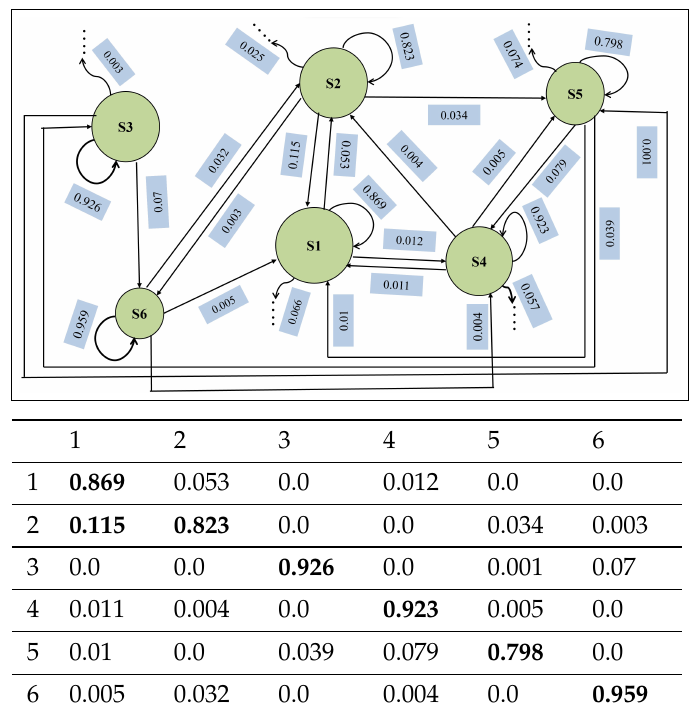
Figure 7. In each case, macro-states are drawn as disks, with radii proportional to size (number of conformations). Transitions between them are drawn as arrows, and transition probabilities are shown. The visual summary is restricted to the six top-populated states. Trailing arrows indicate transitions to other states. Transition probabilities for the six top-populated states (Values at or above 0.1 are highlighted in bold indicating considerable